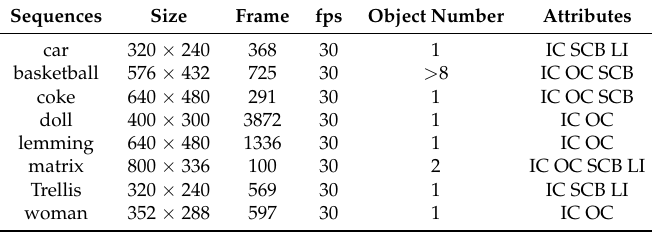
Figure 7. Eight test sequences used in current evaluation. ( a ) basketball; ( b ) car; ( c ) coke; ( d ) doll; ( e ) lemming; ( f ) matrix; ( g ) trellis; ( h ) woman. Table 2. Eight sequences in the